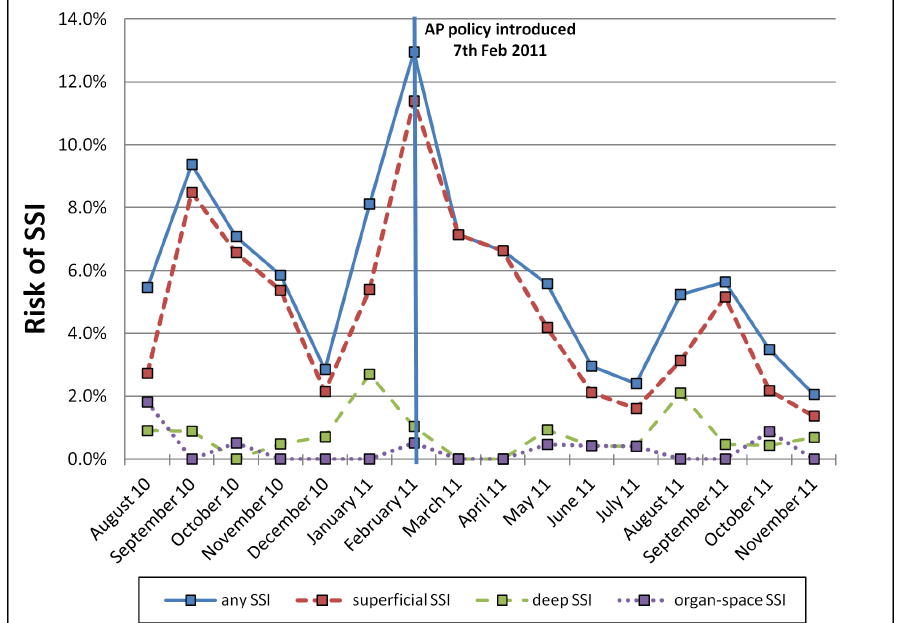
Figure 2. Monthly risk of SSI in Thika Hospital, 2010–11.